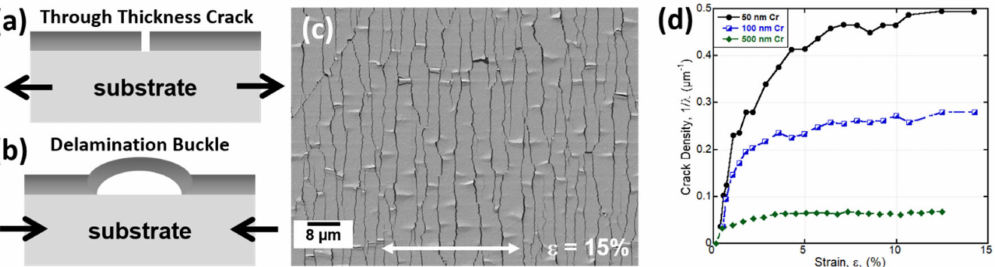
Figure 3. Schematic diagram of ( a ) through thickness cracks (channel cracks) that form perpendicular to the straining direction and ( b ) delamination buckles which form parallel to the straining direction. ( c ) SEM micrograph of a 100 nm sputter deposited Cr film strained to 15% to illustrate cracking and delamination of the film. White arrow indicates the straining direction. ( d ) Crack density evolution for three sputter deposited Cr films (50, 100, 500 nm) on PI illustrating the effect of film